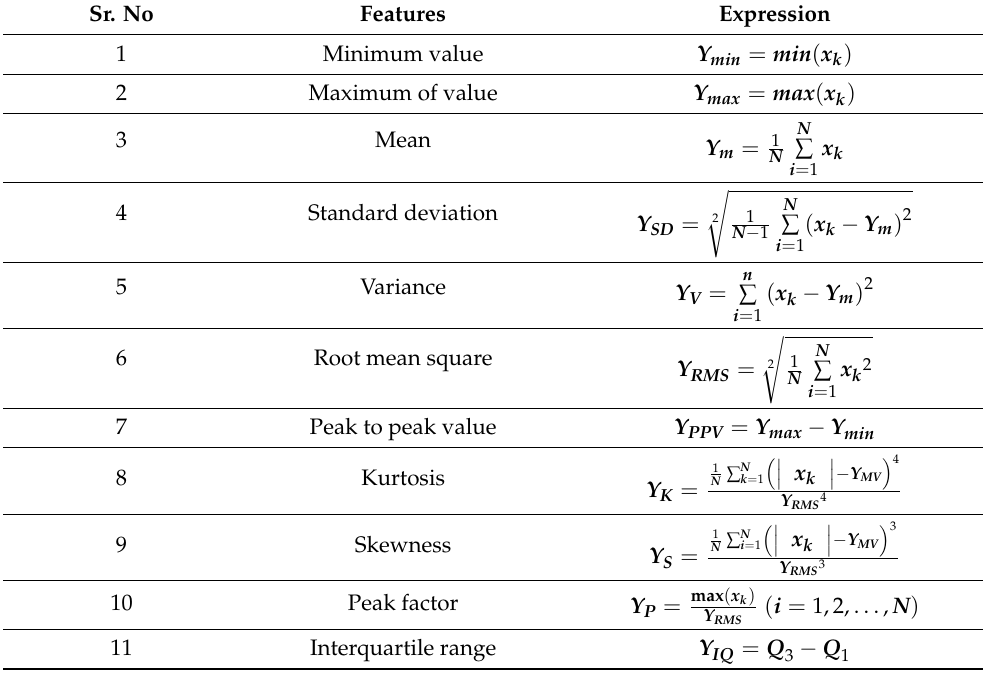
Table 4. Statistical features for the transformation of CFR